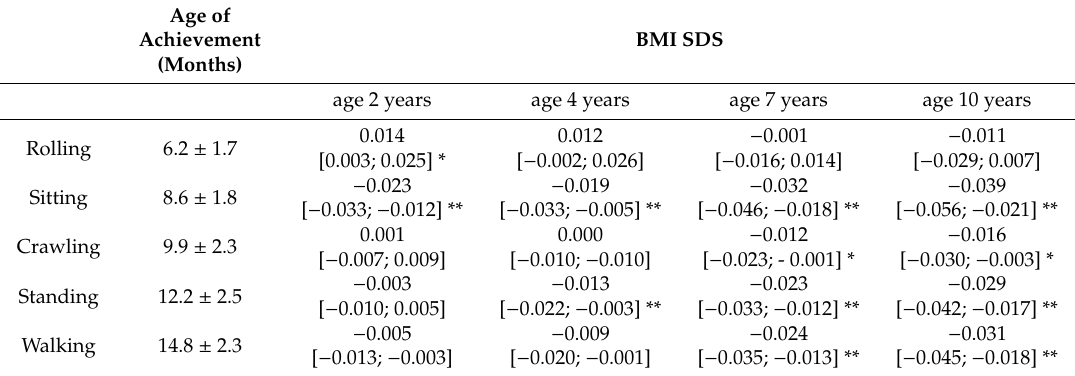
Table 4. Associations between motor milestones and BMI SDS at 2, 4, 7, and 10